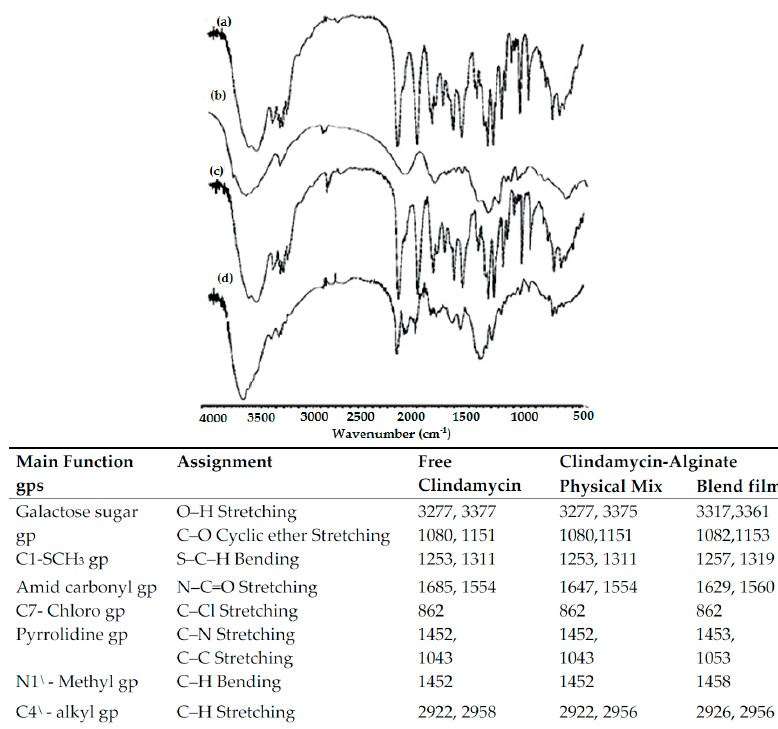
Figure 9. Most effective FTIR bands and spectra of: (a) pure clindamycin; (b) alginate alone; (c) clindamycin-alginate physical mixture; (d) clindamycin-alginate blend film.